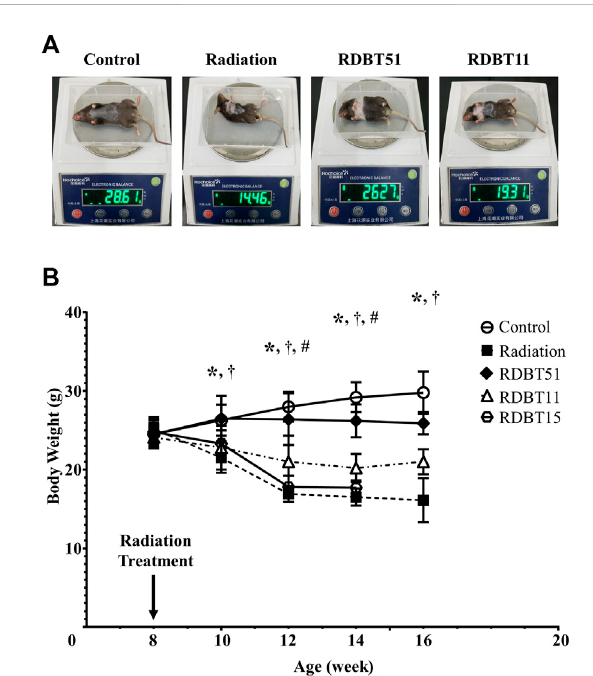
FIGURE 1 The protective effect of DBT on the radiation-induced abnormal weight loss. (A) The representative images of body weighing at 8 weeks after radiation; (B) Trends in body weight change. * p < 0.05 of Radiation versus Control; † p < 0.05 of RDBT51 versus Radiation; # p < 0.05 of RDBT11 versus Radiation. DBT, Dang Gui Bu Xue Tang; RAM, Radix Astragali membranaceus ; RAS, Radix Angelicae sinensis ; RDBT51, Radiation with DBT (RAM: RAS = 5:1); RDBT11, Radiation with DBT (RAM: RAS = 1:1); RDBT15, Radiation with DBT (RAM: RAS = 1:5); The “ R ” in the “ RDBT ” stands for Radiation, while the two digits following RDBT represent the ratio between RAM and RAS, the same below.